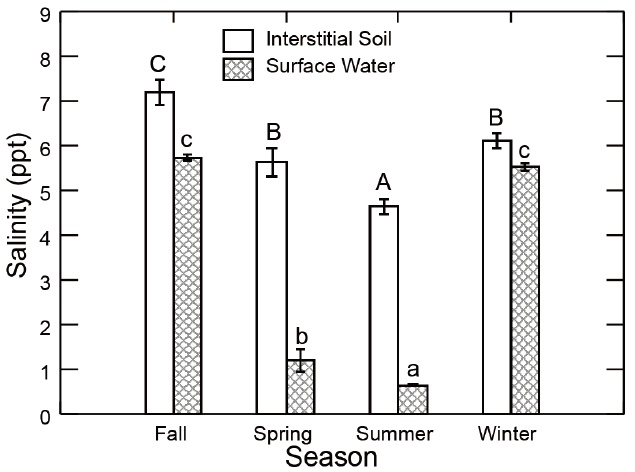
Figure 7. Mean surface water and interstitial soil salinity measured in the CWU in 2011. Different letters indicate a significant difference α = 0.05. Error bars represent standard error of the mean.